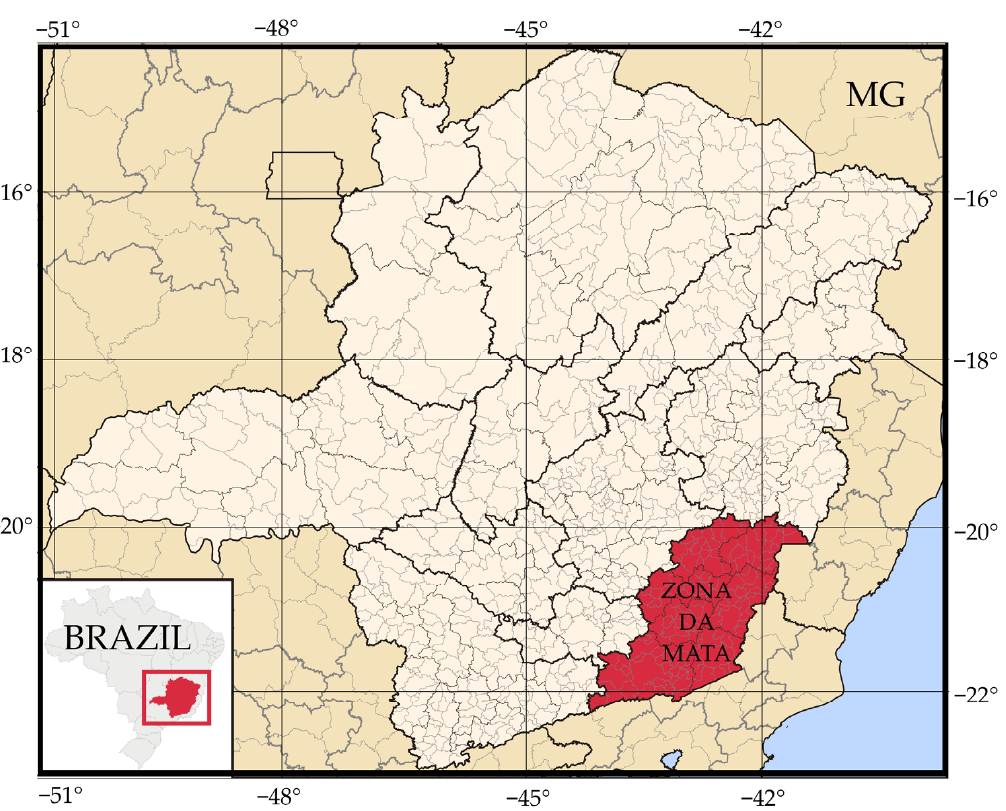
Figure 1. Map with the location of the state of Minas Gerais (MG) in Brazil and the Zona da Mata region (Latitude: between 20 ◦ and 22 ◦ South and Longitude: between 41 ◦ and 44 ◦ West). Adapted from Abreu (2006) [71].